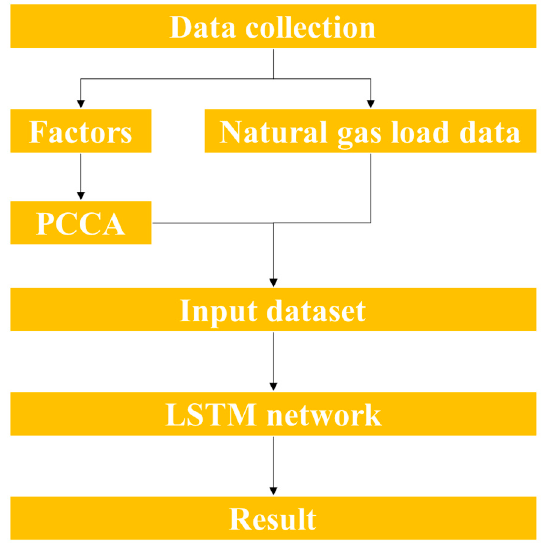
Figure 4. The flowchart of the proposed model, principal component correlation analysis (PCCA)– LSTM.